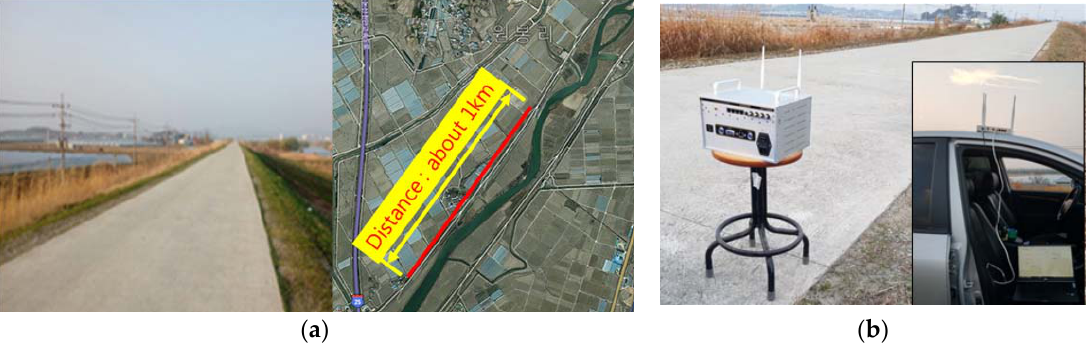
Figure 5. Test of wireless communication distance: ( a ) view of open field; ( b ) test setup in open field.